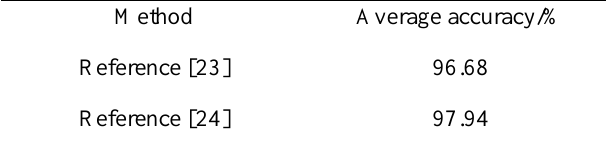
Table 1. Comparison with different methods